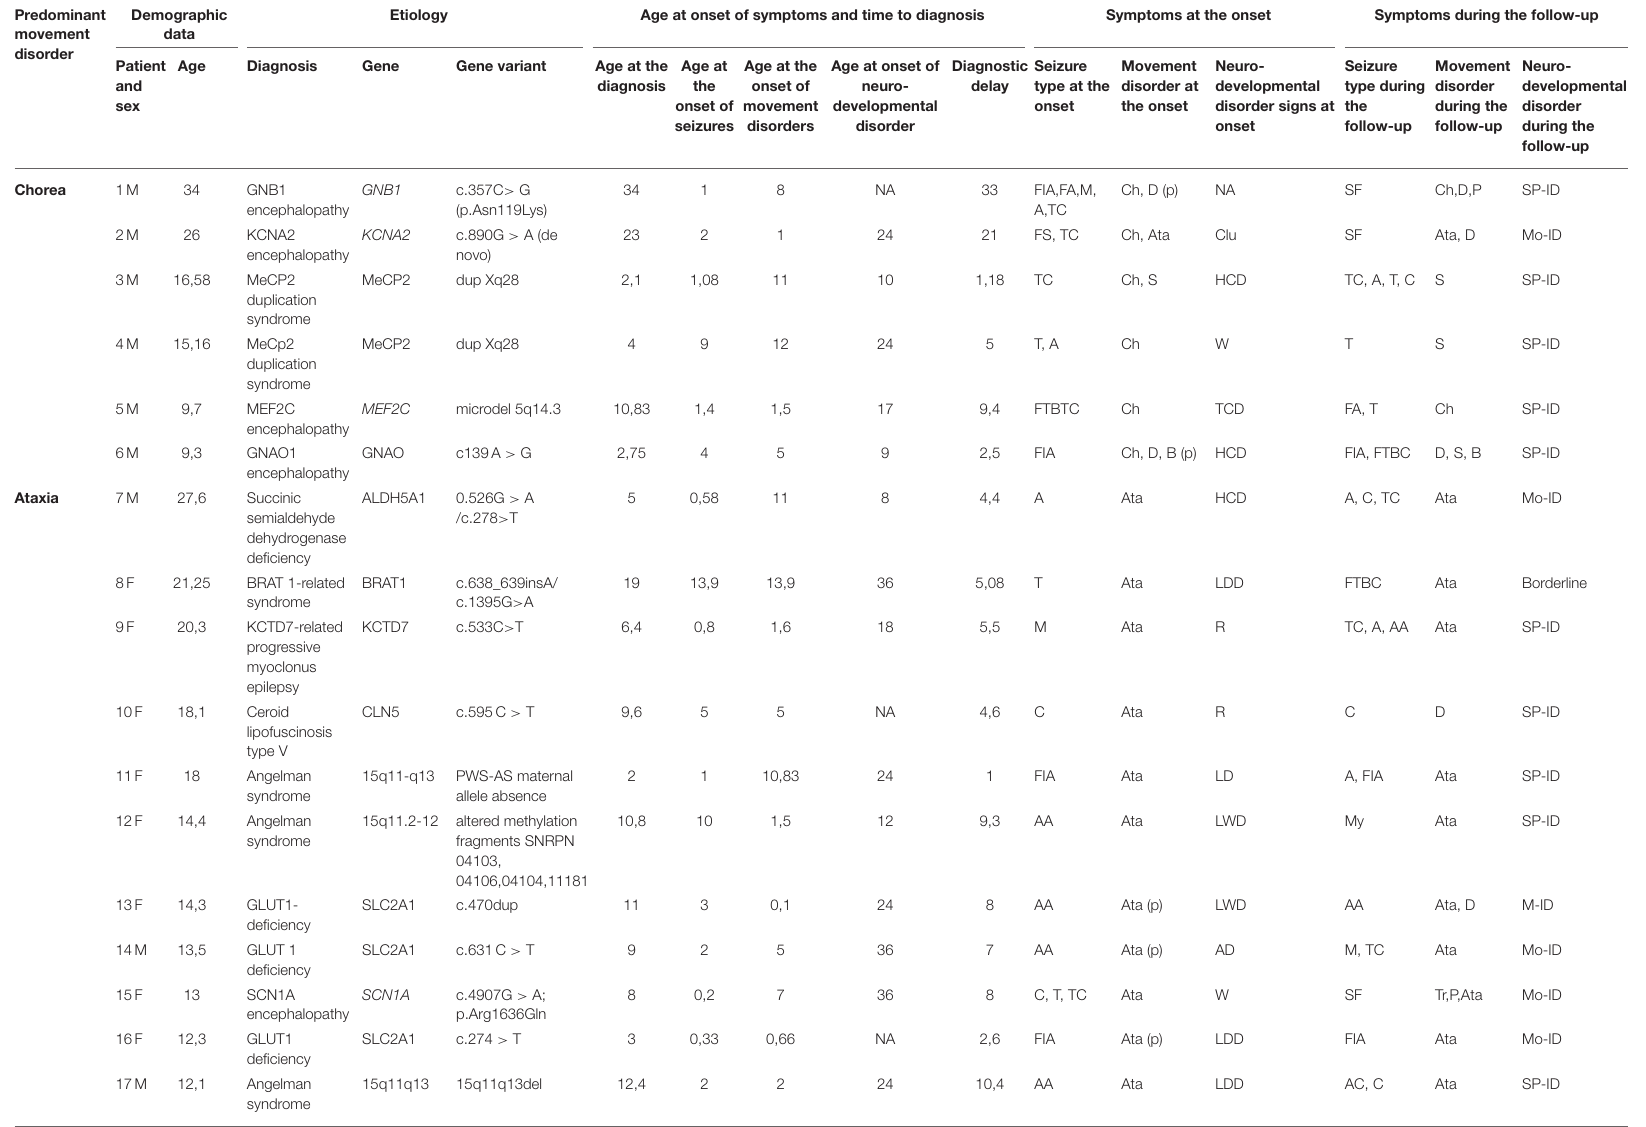
TABLE 1 | Demographic, clinical, and molecular genetics features of patients with developmental encephalopathies presenting with epilepsy and hyperkinetic movement disorders (Group A). Predominant